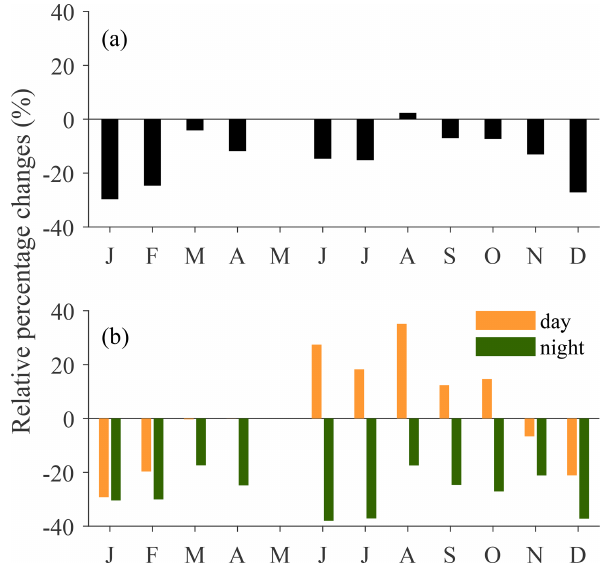
Figure 5. Monthly variations of the relative percentage changes (%) between SHT and SUR for (a) all time, (b) daytime (08:00–19:00), and nighttime (20:00–07:00). The relative percentage changes are calculated as (PM 2 . 5 , SHT – PM 2 . 5 , SUR ) / PM 2 . 5 , SUR ×